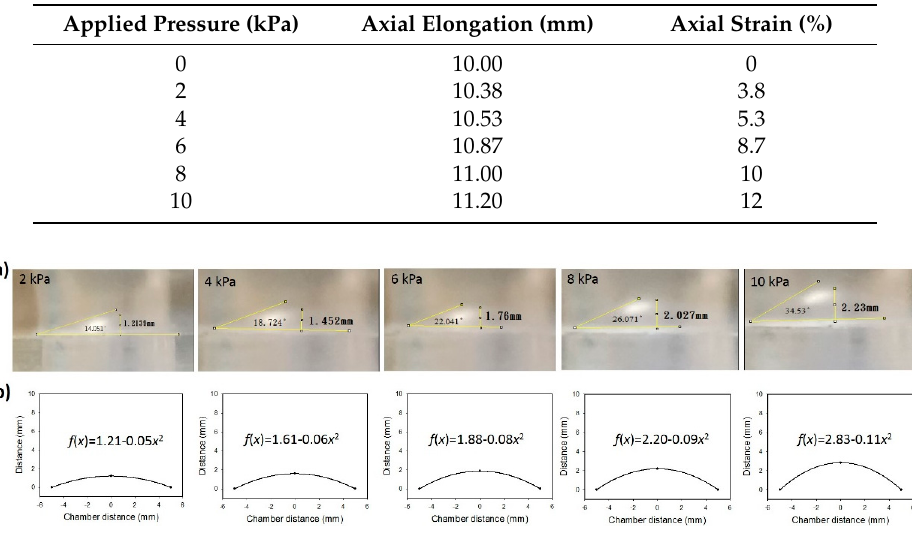
Figure 4. ( a ) Side view photographs of the deformed membrane under different applied pressures. ( b ) Contours of the deformed membrane fitted by quadratic equation.